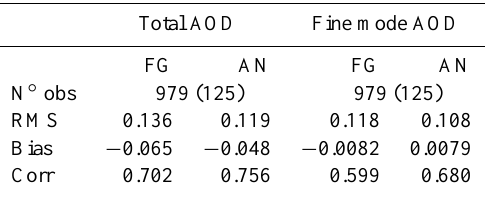
Table 3. Same as Table 2 but with statistics computed with respect to AERONET. Selected stations are illustrated in Fig. 2. Statistics are computed considering the closest model pixel to the AERONET stations and monthly average is computed using only days with AERONET observations. The number of monthly means used to compute the statistics is given in the first row while the number of stations used is given in